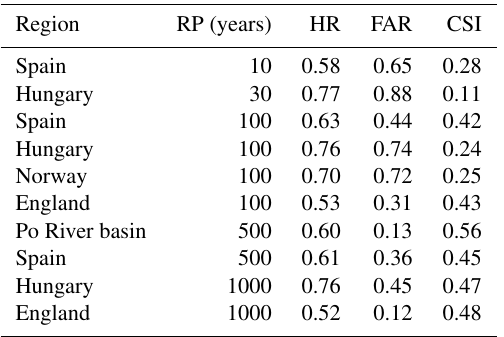
Table 3. Results of the validation against official flood hazard maps. Value of the performance indices at country and regional scale.